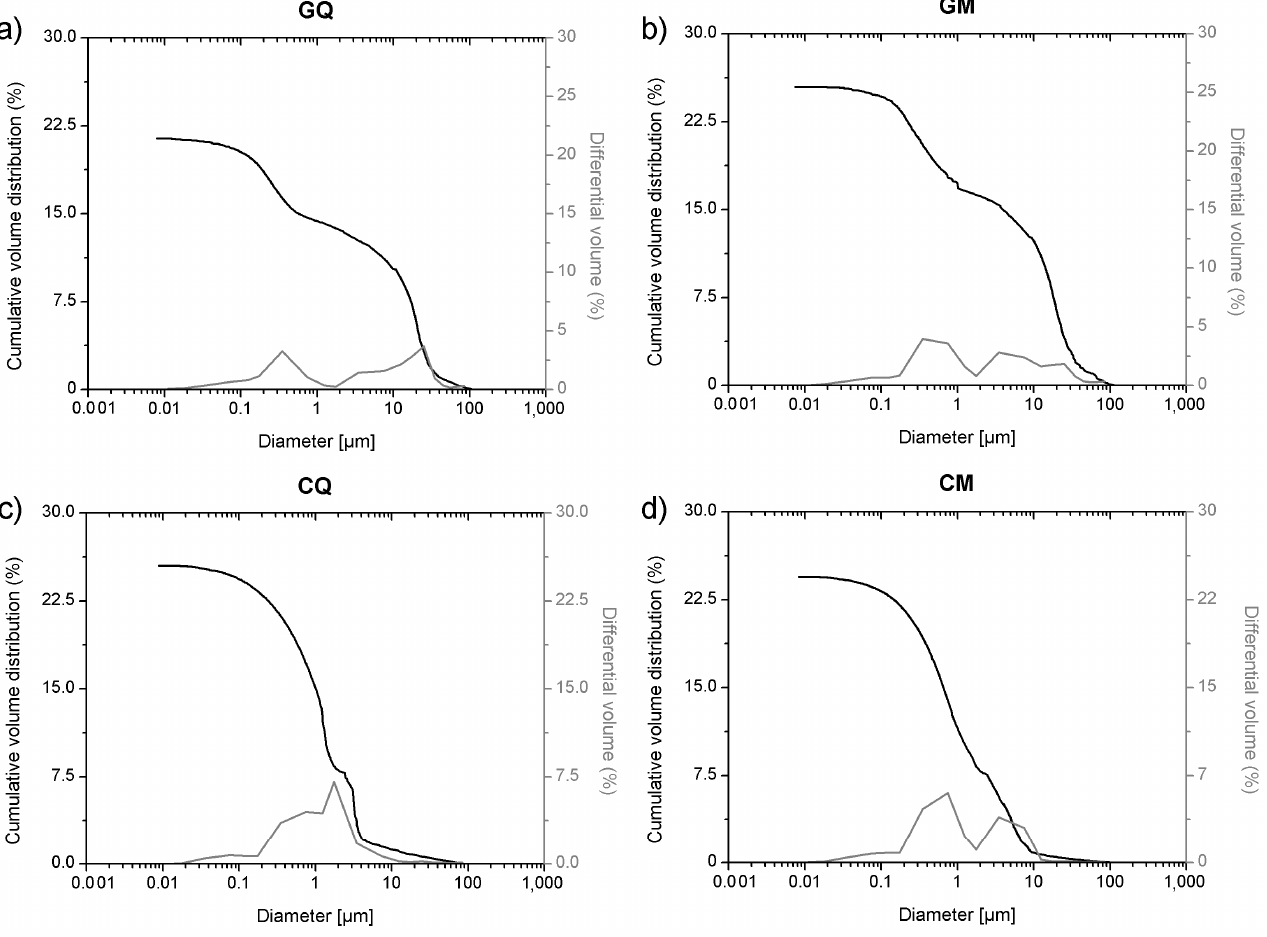
Figure 4. MIP cumulative volume distribution (black) and differential volume (gray) of samples with aerial lime: ( a ) GQ, ( b ) GM, ( c ) CQ and ( d )